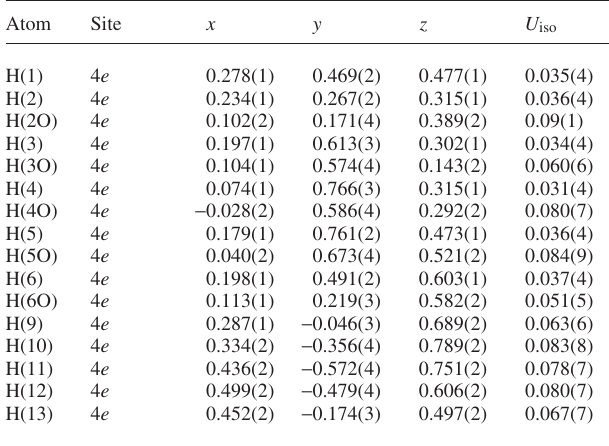
Table 2. Atomic coordinates and displacement parameters (in Å 2 )